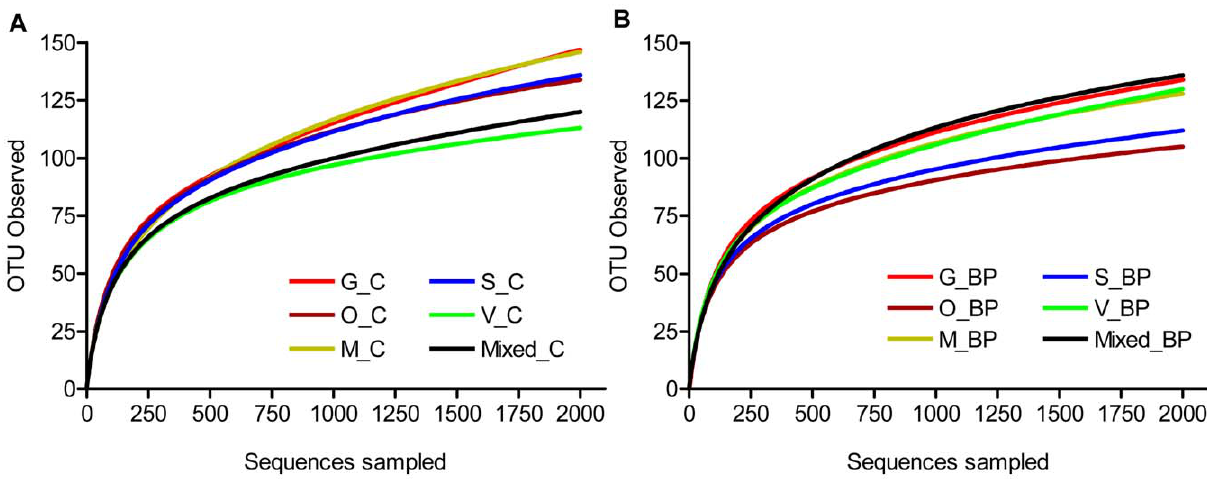
Figure 1. Rarefaction analysis of V3 16S data from canine fecal samples. ( A ) Dogs fed a low-fiber control diet. ( B ) Dogs fed a diet supplemented with beet pulp fiber. Each line represents a single animal or a pooled sample. Analysis was performed on a random 2,000- sequence subset from each sample. Operational Taxonomical Units (OTU) in this analysis were defined at 96% similarity.